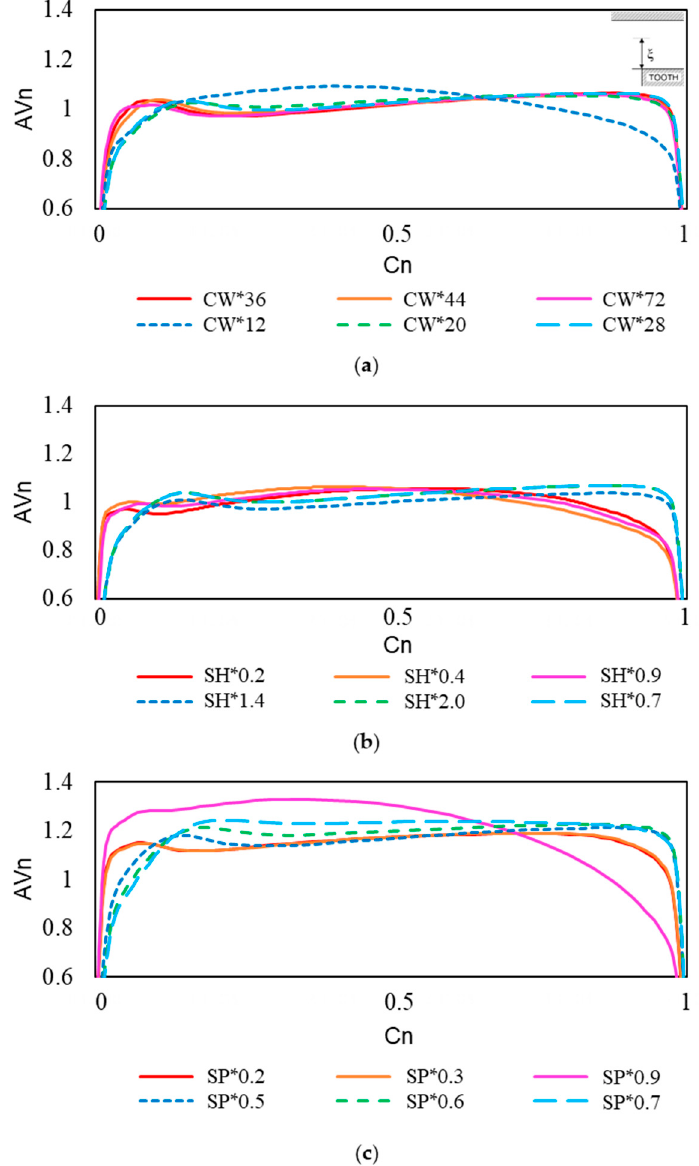
Figure 12. Normalized axial-velocity changes by geometrical parameter at the second tooth. ( a ) CW. ( b ) SH. ( c ) SP.